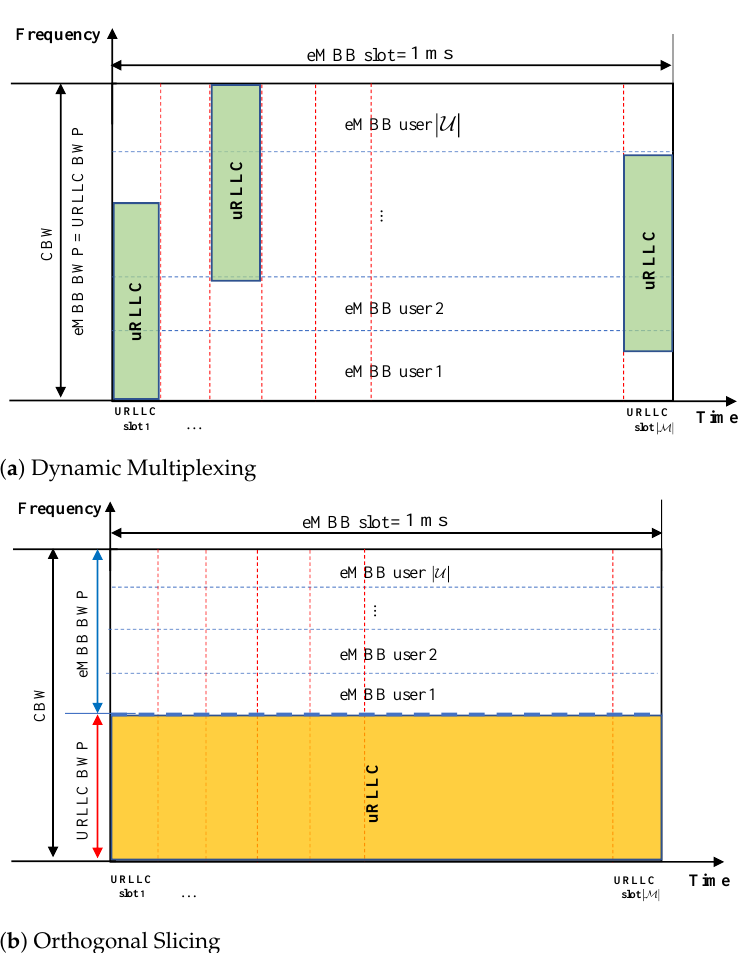
Figure 2. Two different eMBB/URLLC multiplexing: DM vs.